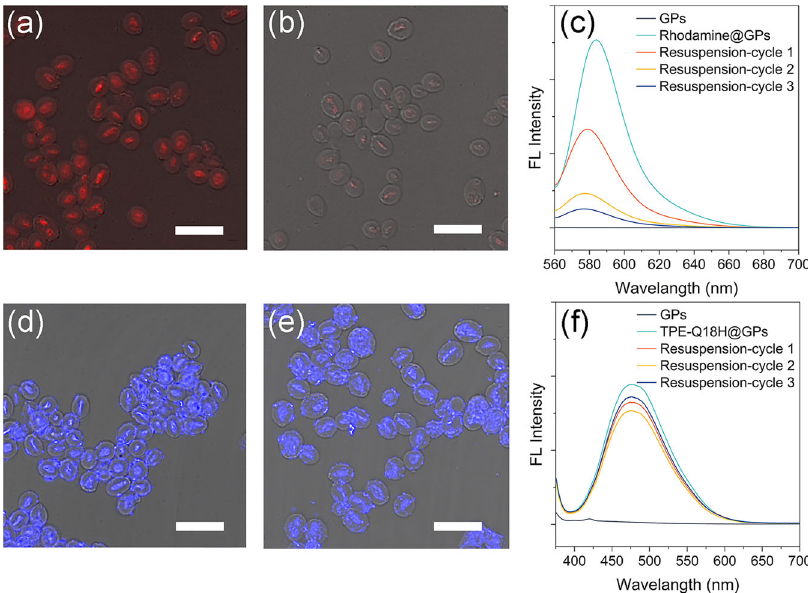
Fig. 4 Semi-permeability was assessed by CLSM and fl uorescence spectrophotometry. CLSM images of a free GPs were incubated with Rhodamine for 10 min (Rhodamine@GPs) and b Rhodamine@GPs after three times centrifugation. c Fluorescence intensity changes of Rhodamine@GPs during three times centrifugation. CLSM images of d TPE-Q18H@GPs and e TPE-Q18H@GPs after three times centrifugation. f Fluorescence intensity changes of TPE- Q18H@GPs during three times centrifugation. Scale bar: 10 μ m. In fl uorescence spectra, λ ex = 365 nm for TPE and λ ex = 540 nm for Rhodamine, in CLSM images λ ex = 405 nm for TPE and λ ex = 561 nm for Rhodamine.